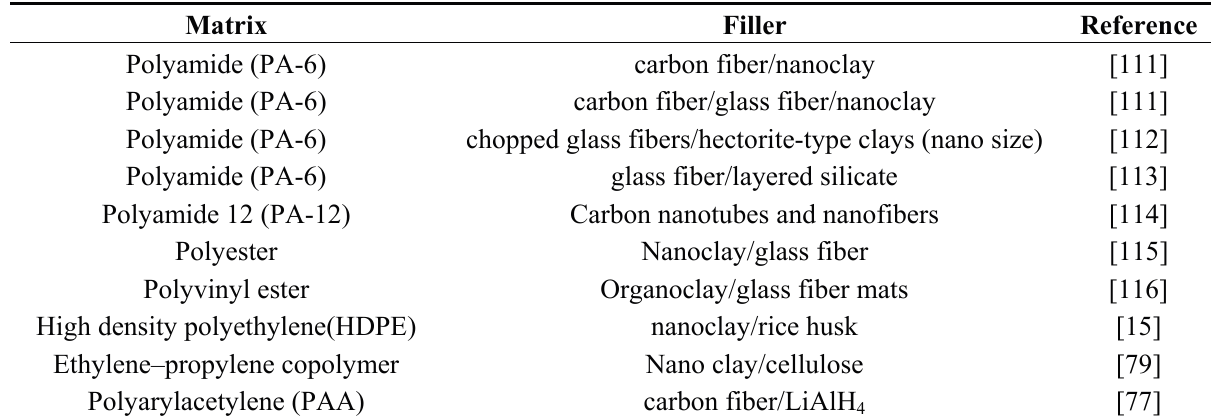
Table 10. Reported work on fiber/nanofiller hybrid